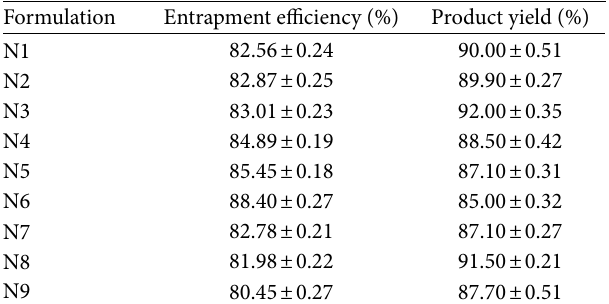
Average of three determinations, ±SD (standard